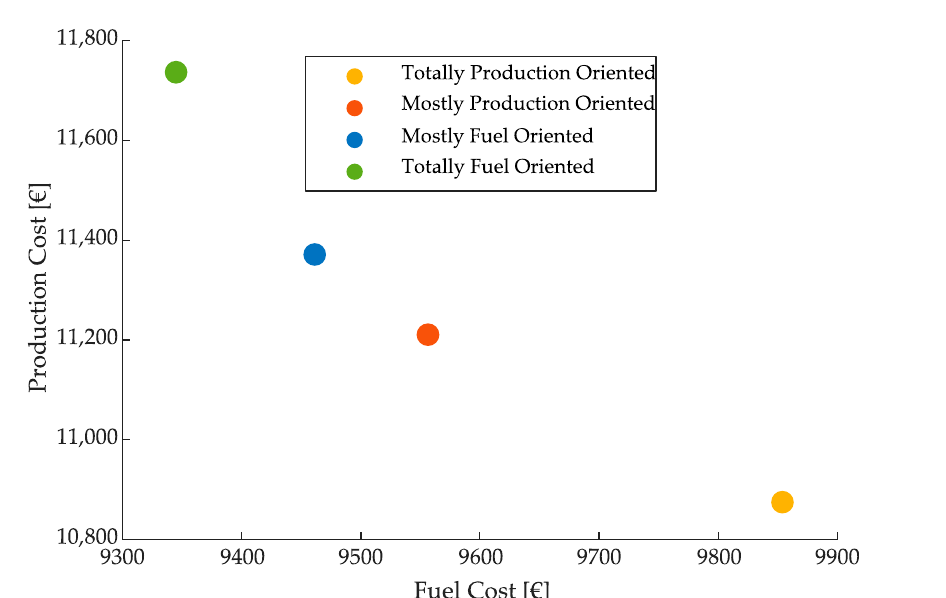
Figure 8. HEV optimal layouts for the different objective functions implemented in the PSO algorithm expressed in a Pareto frontier.